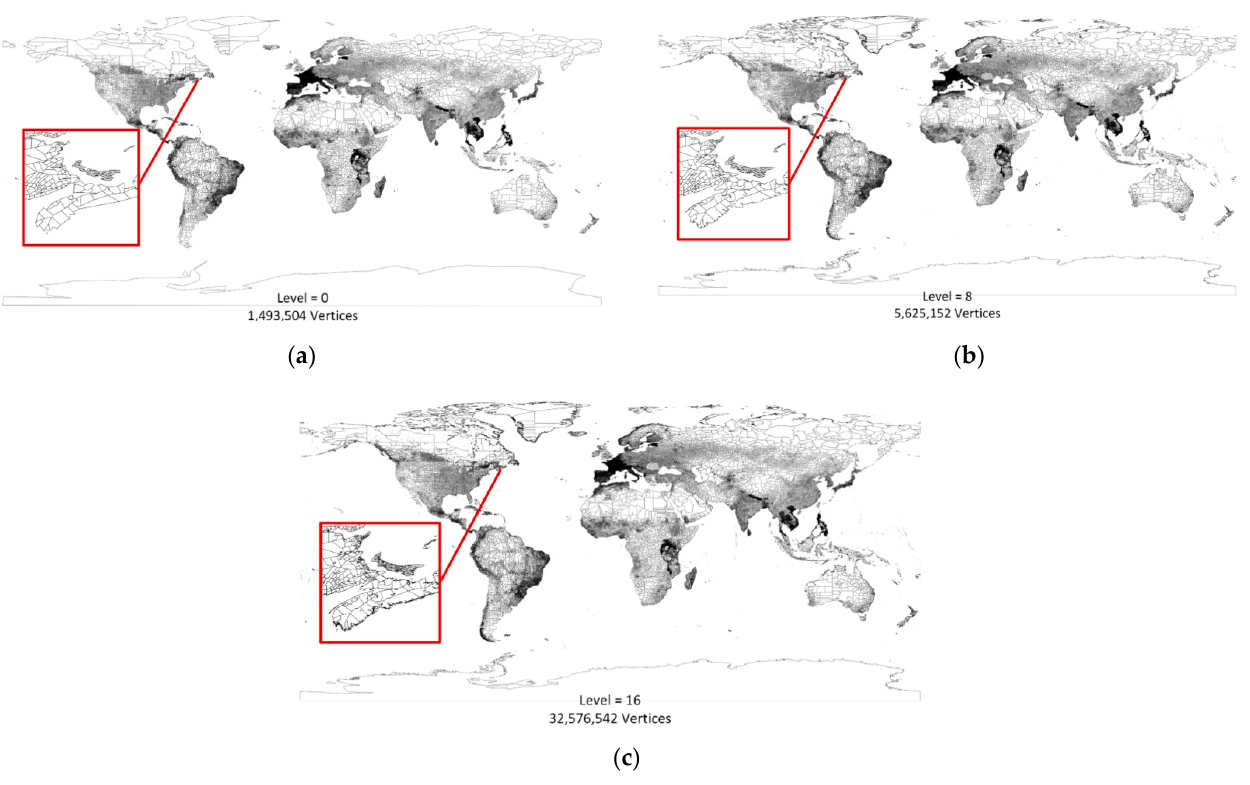
Figure 6. Vector tiles at different levels of the VTPM for global administrative map. ( a ) Map contains 1,493,504 vertices when level is 0. ( b ) Map contains 5,625,152 vertices when level is 8. ( c ) Map contains 32,576,542 vertices when level is 16. Table 2. The number of vertices at different levels for global rail and global road.